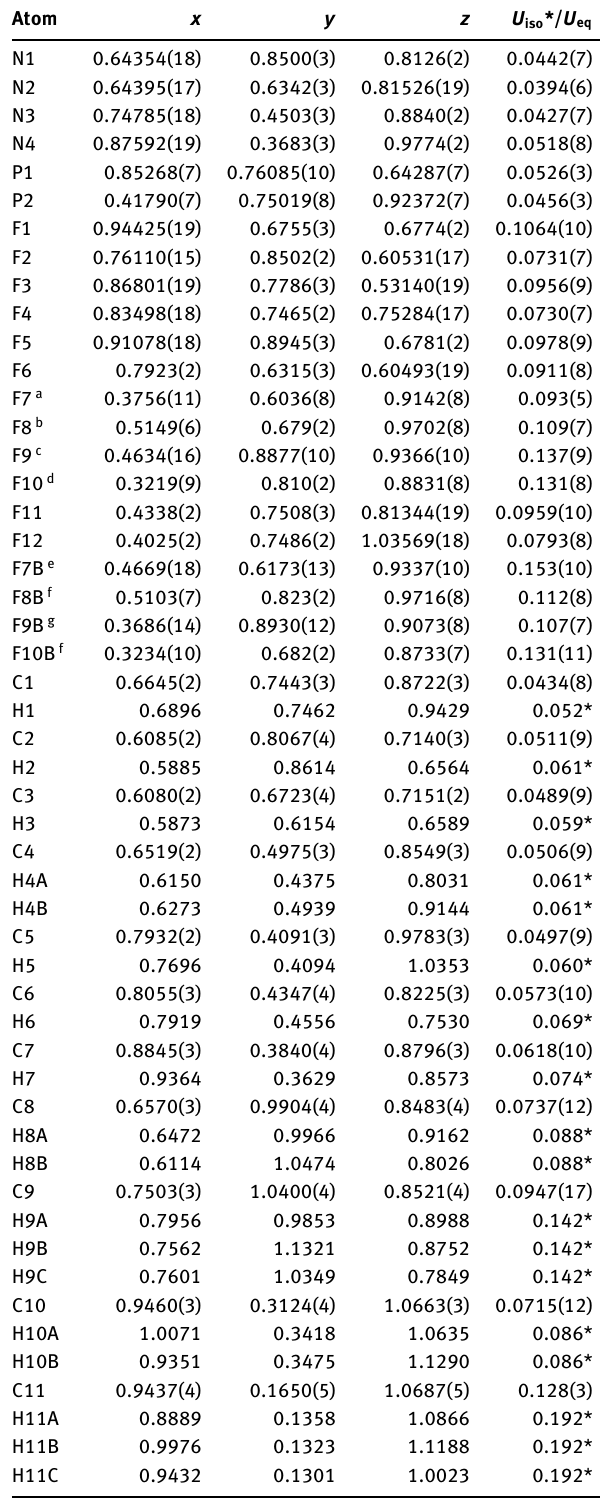
Table 2: Fractional atomic coordinates and isotropic or equivalent isotropic displacement parameters (Å 2